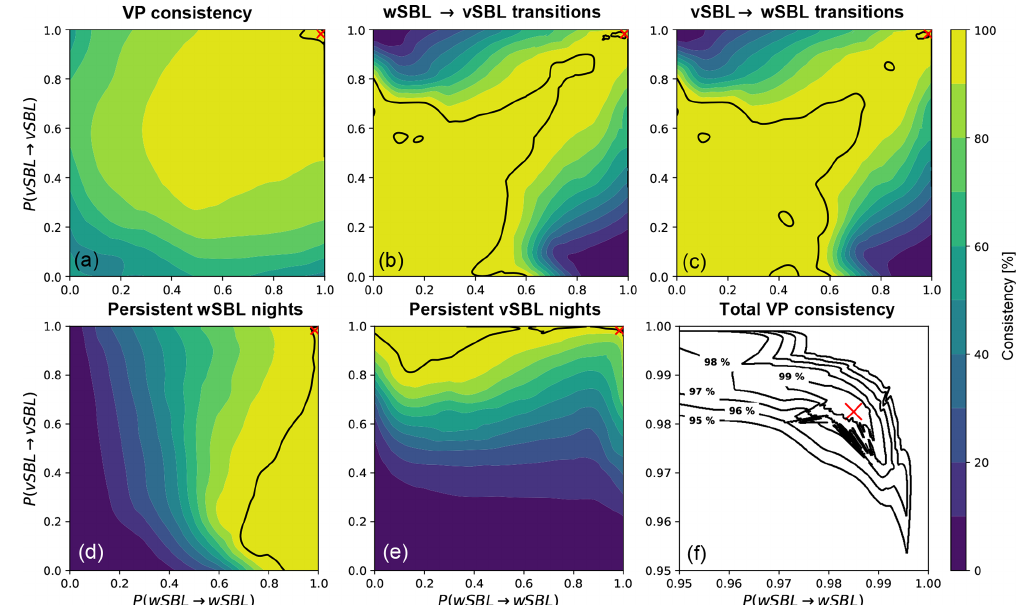
Figure 5. Consistency of reference and perturbed regime occupation statistics as functions of Markov chain persistence probabilities at Cabauw. Displayed are the occupation consistency of the VP (a) , the consistency of wSBL to vSBL (b) and vSBL to wSBL (c) transitions in the VP, and the consistency of the occurrence of very persistent wSBL (d) and vSBL (e) nights. The 99% consistency values in each of these subpanels is delineated by a black line. Isolines of the total consistency of the perturbed and reference VP (ranges of persistence probabilities where all SBL regime statistics considered have the same or higher consistencies with VP ref ) are illustrated in panel (f) . In each panel the reference value at Cabauw is shown by a red